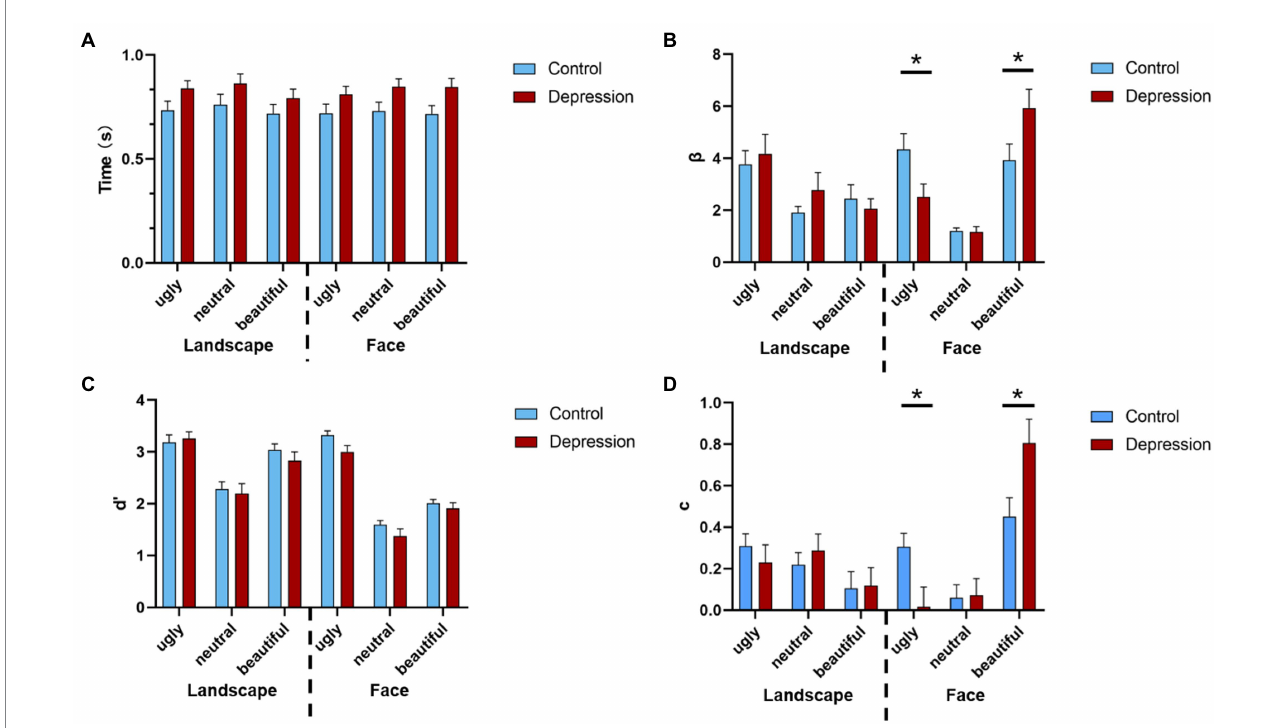
FIGURE 2 (A) The reaction times (RT) of the aesthetic judgments are shown as a function of the stimuli type, valence, and group. Error bars indicate standard errors. (B) The response bias is shown as a function of stimuli type, valence, and group. (C) The perceptual sensitivity is shown as a function of stimuli type, valence, and group, and (D) the judgement criterion is shown as a function of stimuli type, valence, and group. Error bars indicate standard errors. * indicates a significant difference.